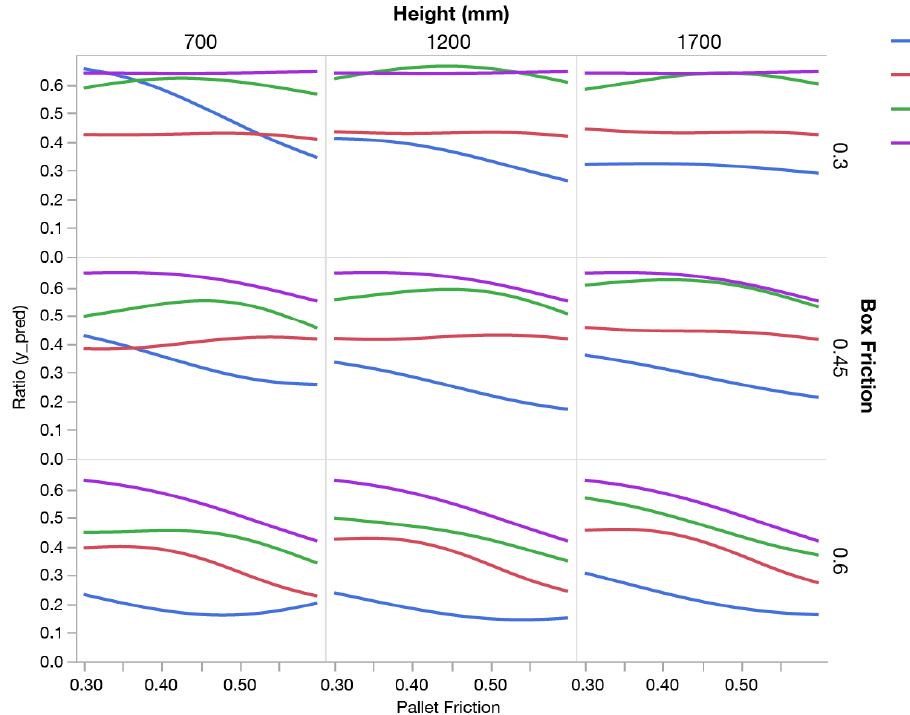
Figure 12. Effect of pallet friction coefficient on board bending ratio by payload height (mm), box friction, and number of columns.